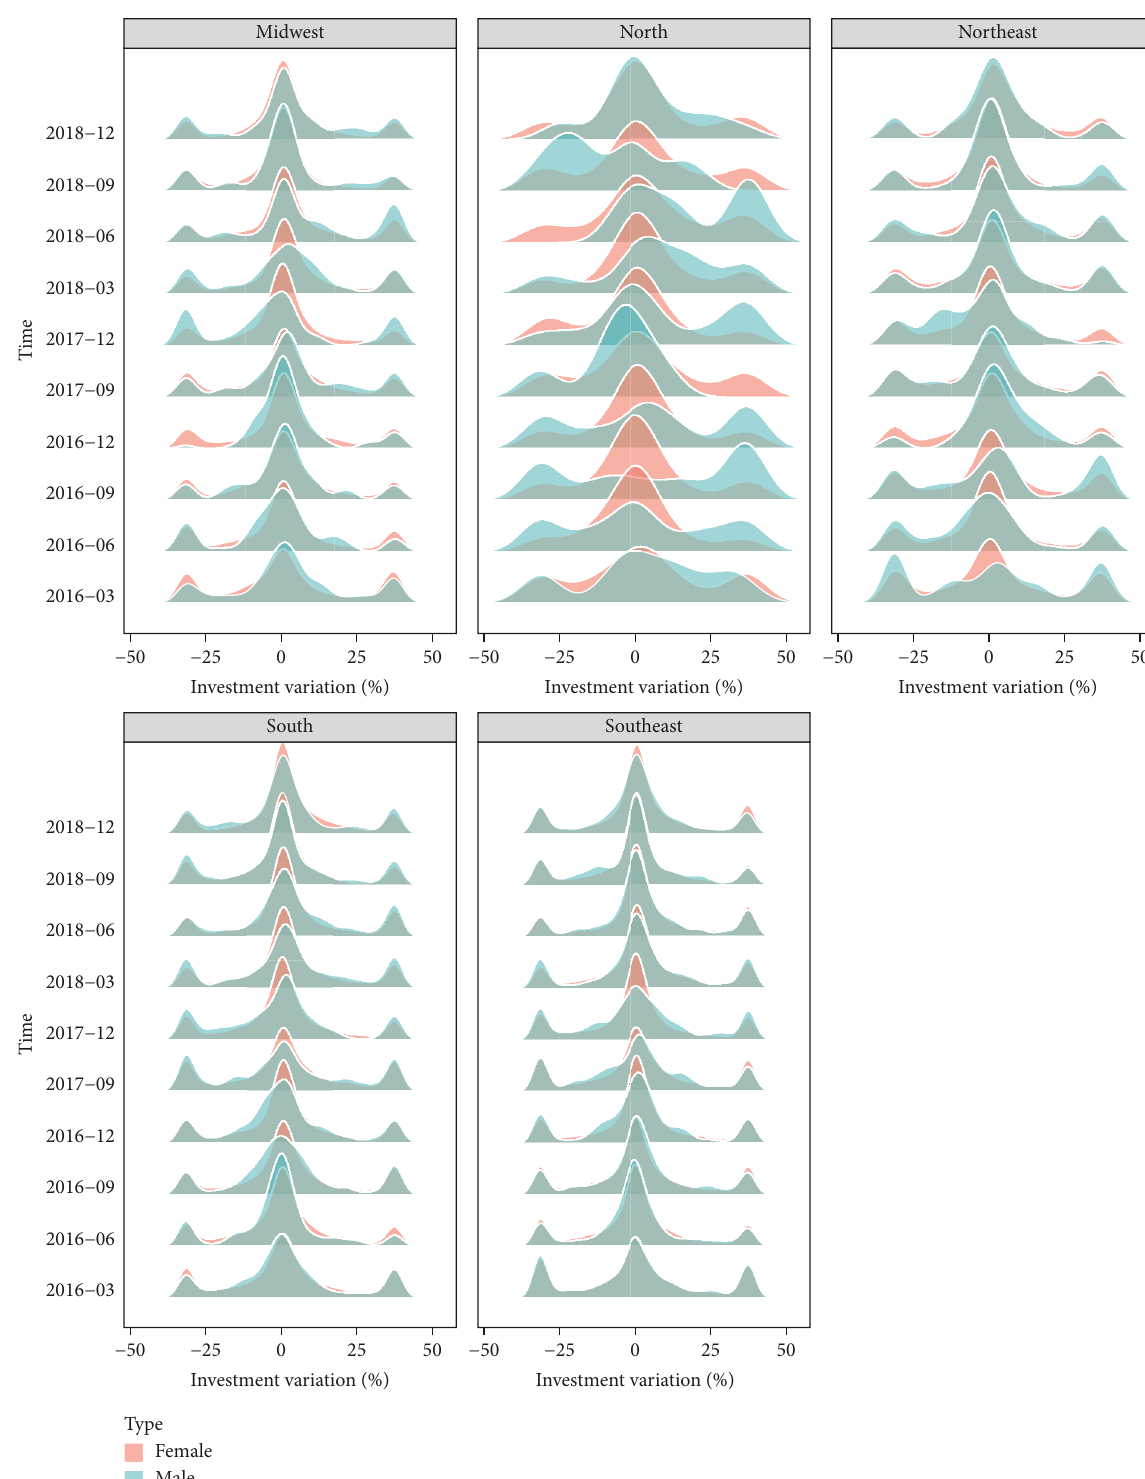
Figure 3: Distribution of investment variation across different Brazilian states (Midwest, North, Northeast, South, and Southeast) broken down by investor’s gender (female or male). Due to the existence of some large absolute values and to improve readability, we winsorize the investment variation distribution by 5% at each